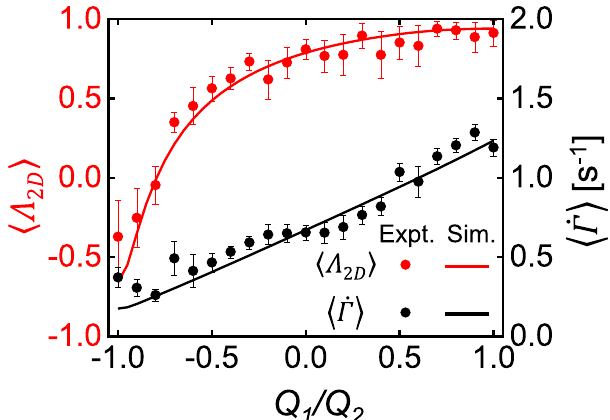
Figure 5. Quantitative comparison of flows of a Newtonian fluid in the FFoRM geometry determined by experiment (points) and simulation (lines). Variations in the volume averaged 2D flow type parameter ( Λ 2 D , red) and magnitude of velocity gradient tensor ( 〈 Γ  〉 , black) are plotted as a function of the operating parameter ( Q 1 / Q 2 ) for constant Q 2 = 1.0 mL/min ( Re = 0.005). Error bars in the experimental measurements indicate the standard deviations in the beam region of the measured average